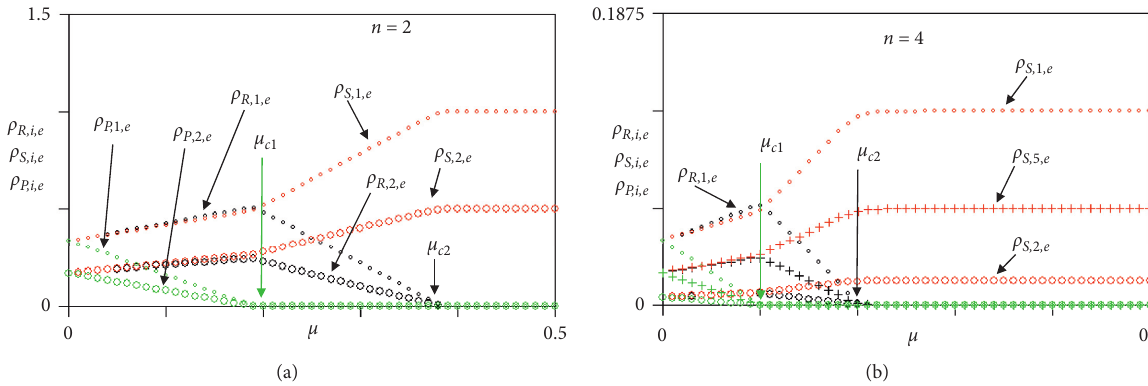
Figure 2: (a) Plots of steady-state densities ρ ( i � 1 , 2 ) of RSP individuals against mutation rate μ for a diffusively-coupled R,i,e , ρ S,i,e , and ρ P,i,e RPS game with mutation for the second generation ( n � 2 ) in Figure 1(a). Black, red, and green circles indicate the steady-state densities of RSP individuals, respectively. Small and large circles indicate the steady-state densities on nodes 1 and 2, respectively. (b) Plots of steady- state densities ρ R,i,e , ρ S,i,e , and ρ P,i,e ( i � 1 , 2 , 5 ) of RSP individuals against mutation rate μ for the diffusively-coupled RPS game with mutation on the fourth generation ( n � 4 ) . Black, red, and green circles indicate the steady-state densities of RSP individuals, respectively. Small and large circles indicate the steady-state densities on nodes 1 and 2, respectively. Crosses indicate the steady-state densities of RSP individuals on node 5.